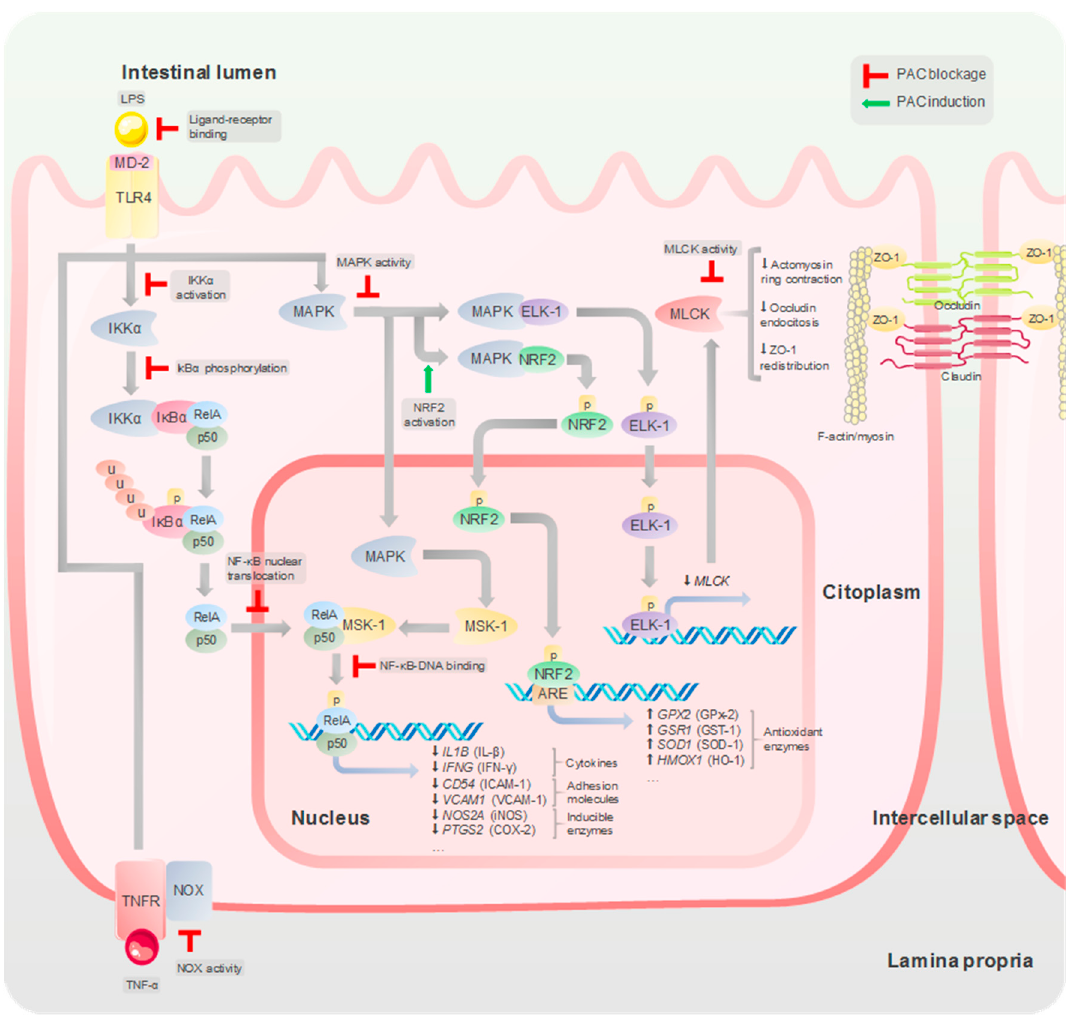
Figure 3. Molecular mechanisms implicated in the physiological effects of PAC in the intestinal mucosa. PACs suppress inflammation interacting with bacterial endotoxins, as well as protein receptors, kinases and transcription factors involved in the pro-inflammatory signaling (NF- κ B and mitogen-activated protein kinases (MAPK) pathways). Oxidative stress is mitigated directly by free-radical scavenging and indirectly by the activation of factor-erythroid-2-related factor 2 (NRF2), leading to antioxidant enzyme production via antioxidant responsive element (ARE) binding.